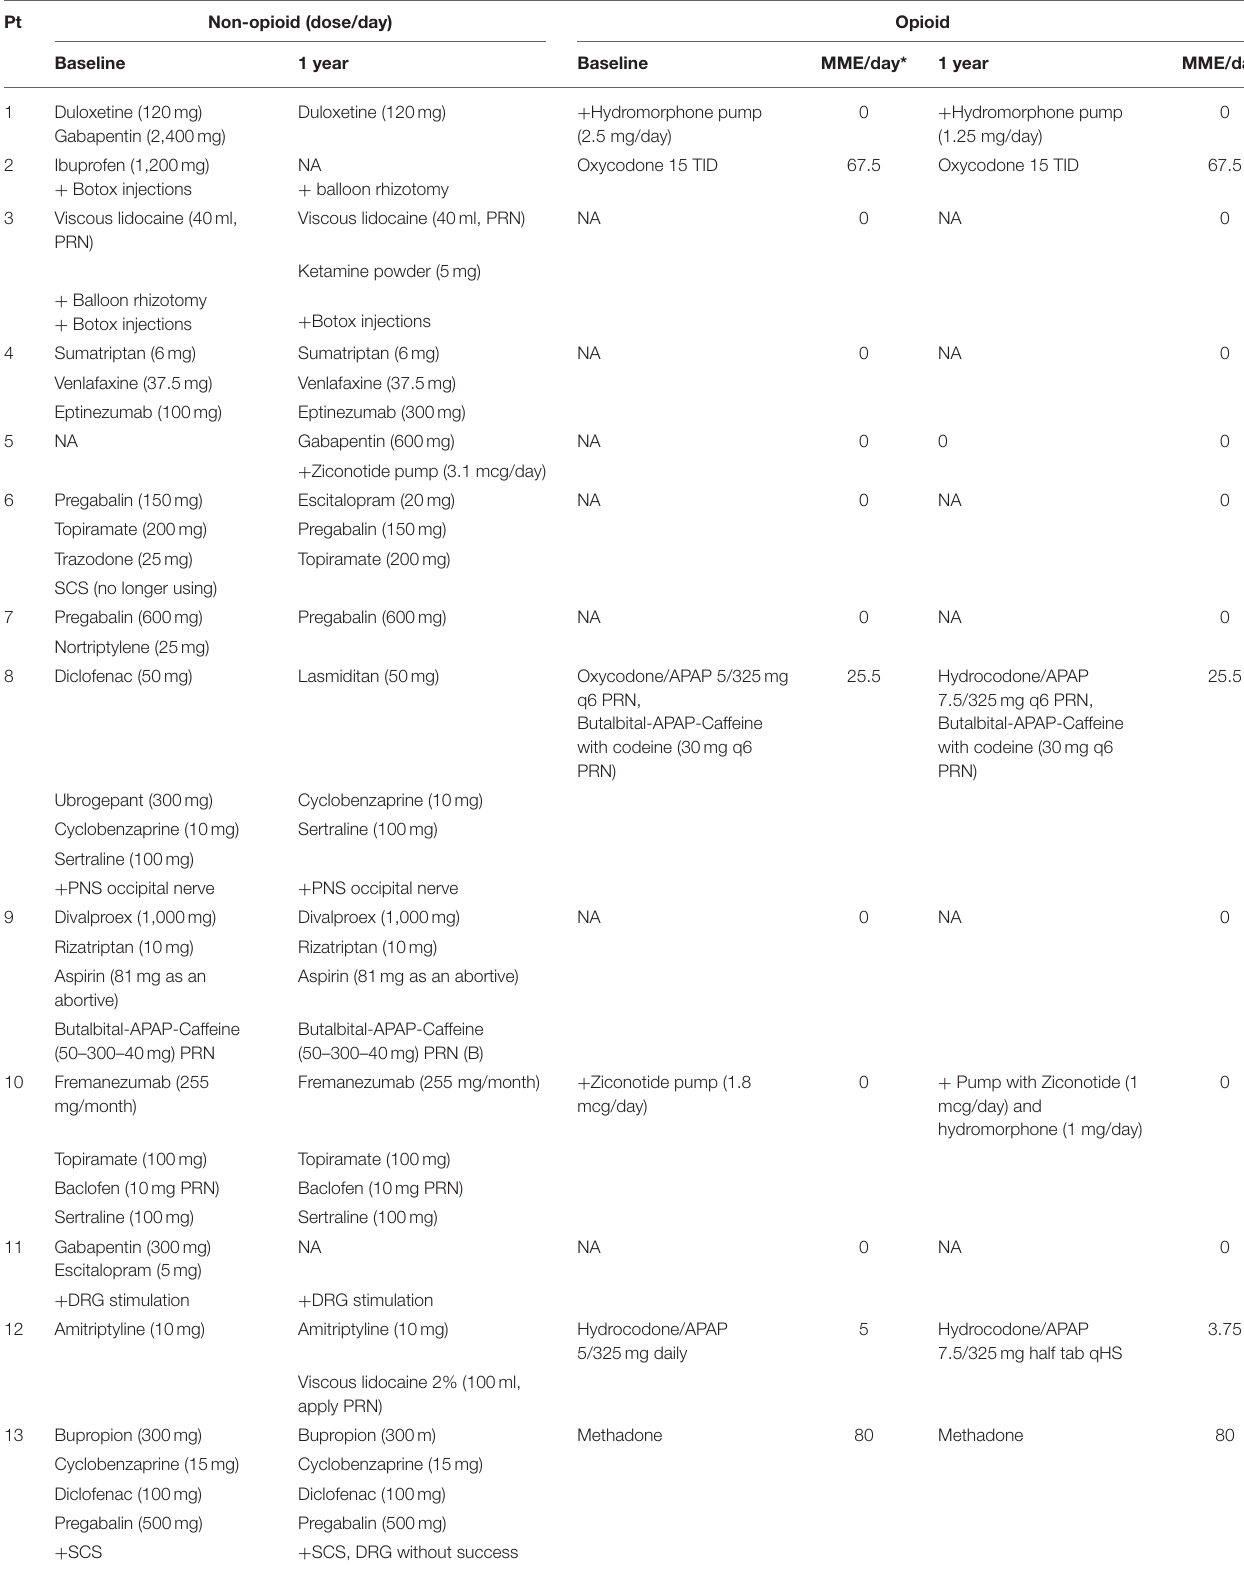
TABLE 2 | Medications and